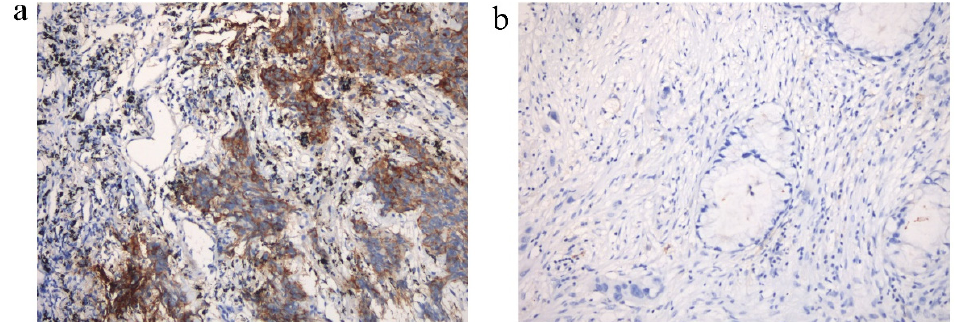
Figure A2. The expression of PD-L1 within non-small cell lung cancer (NSCLC) patients with liver metastasis. ( a ) Positive expression of PD-L1 (PD-L1 TPS = 40%); ( b ) negative expression of PD-L1 (PD-L1 TPS < 1%).